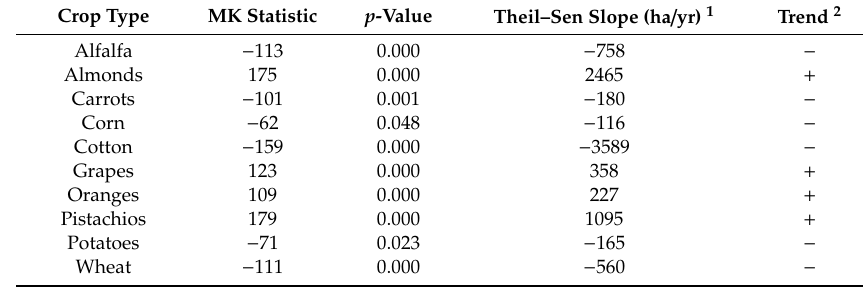
Table 7. Simple Mann–Kendall trend results for the area of 10 major commodities in Kern County from 1999 to 2018 showing: (1) Mann–Kendall trend statistic, (2) p -value, (3) Theil–Sen slope (in hectares) from 1999 to 2018, and (4) the significant trend where ( + ) and ( − ) indicate statistically significant increasing or decreasing, respectively, trends where the p -value is less than 0.05 and (#) signifies the trend is not statistically significant and the p -value is greater than